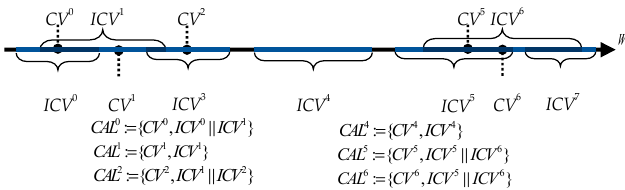
Figure 5. Schematic diagram of cascading adjacent candidate intervals.